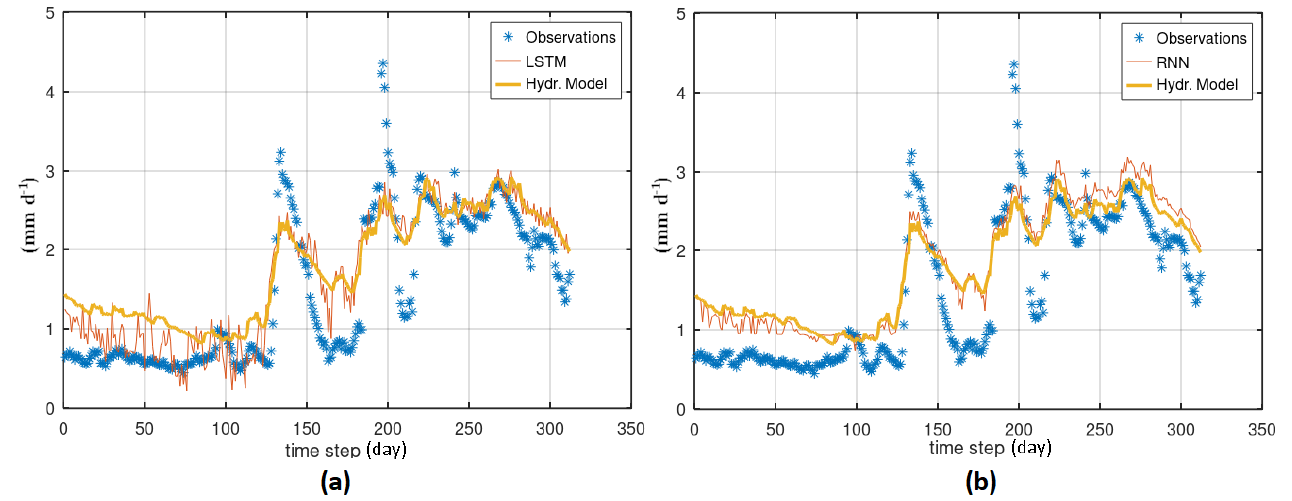
Figure 11. Assessment of the LRHM model in the Nyangores River. LSTM ( a ) and RNN ( b ) employed to approximate the best model that can be obtained with the available data during the LRHM test period.